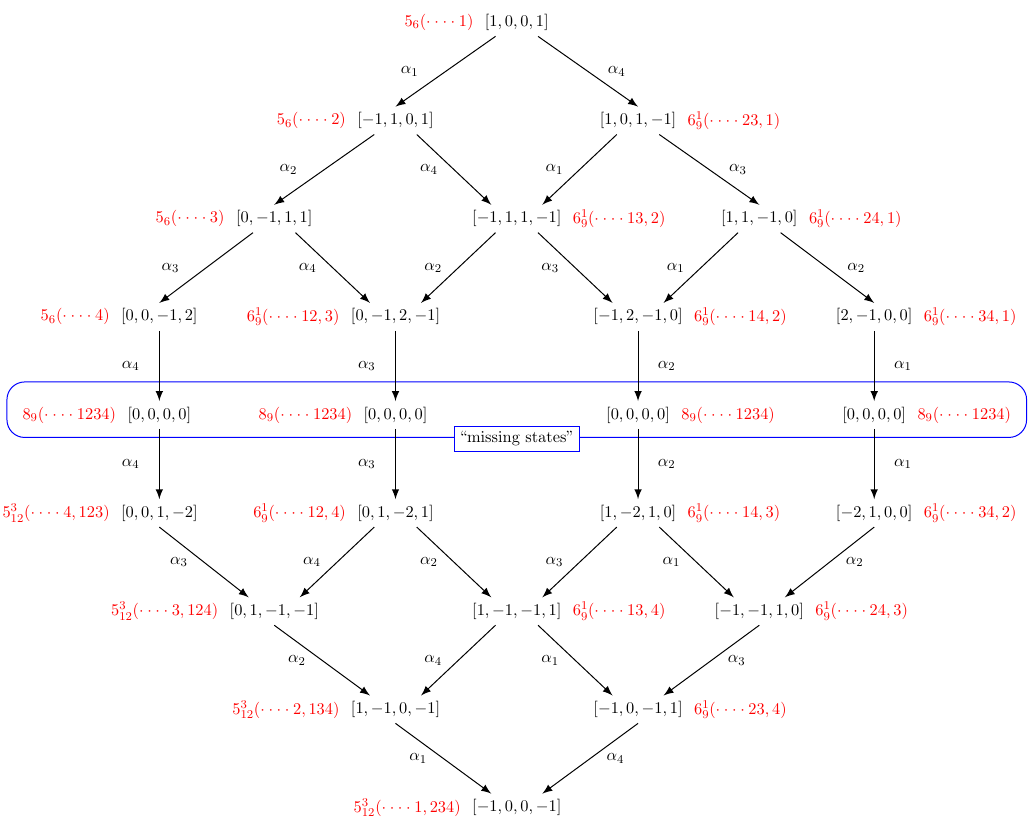
Table 5 . The weight diagram for the 4-brane multiplet in M-theory compactified on T 4